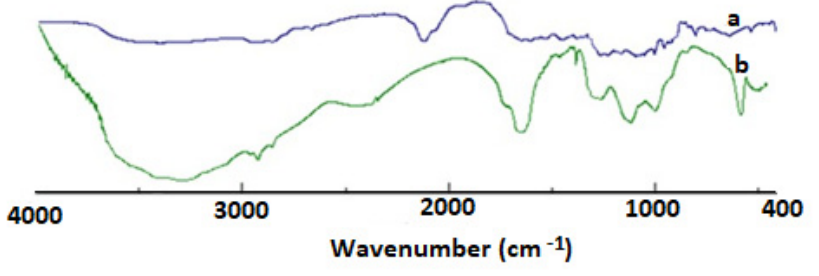
Figure 1. FTIR of CC (a) and CC- α -T (b). Figure 1. FTIR of CC ( a ) and CC- α -T ( b ).